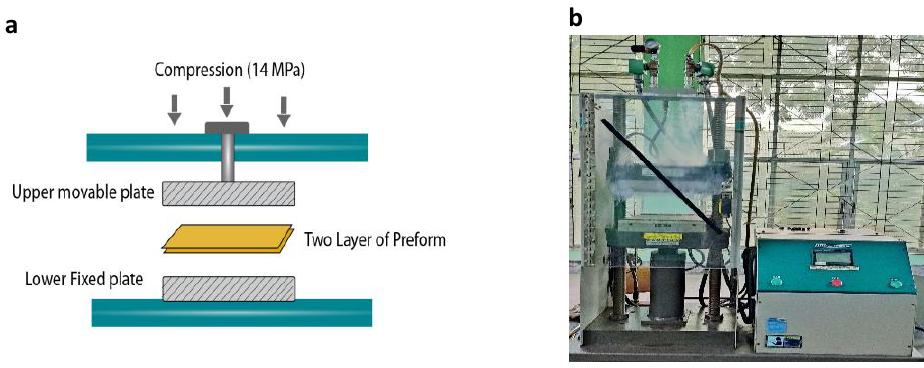
Figure 2. ( a ) Compression moulding schematic process used to fabricate composite laminates ( b ) Carver compression machine used in this study. Table 3. Measured and calculated physical properties of the composites.